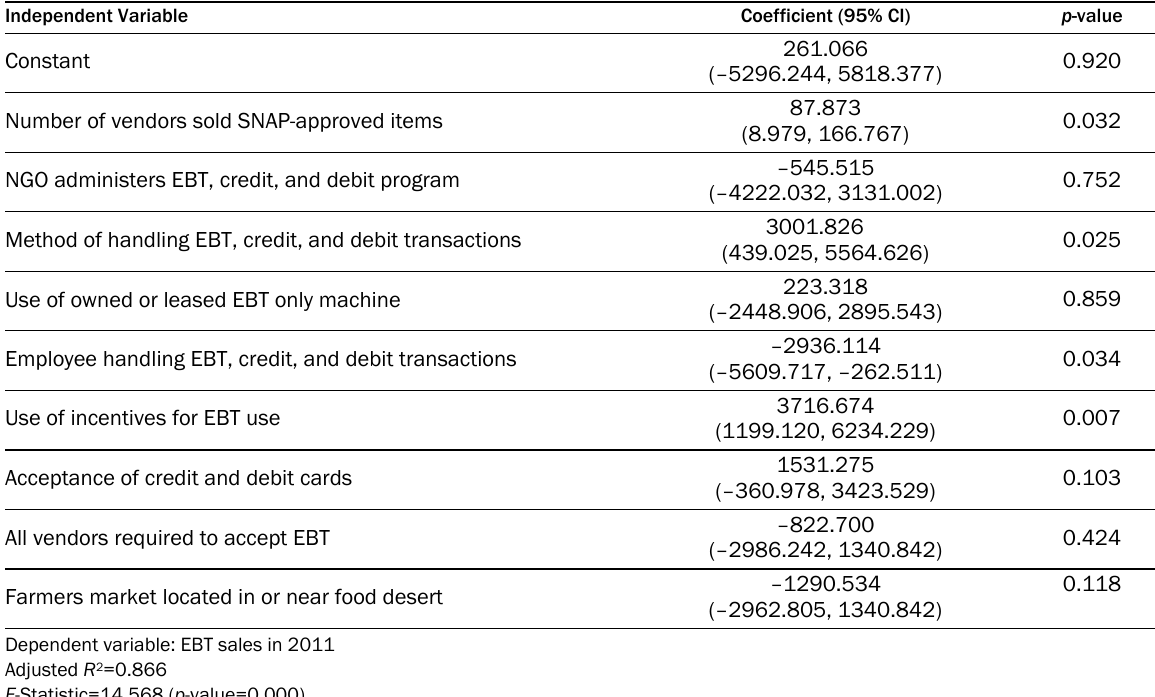
Table 2. Regression Results Showing Determinants of EBT Sales in Illinois Farmers Markets in 2011 Independent